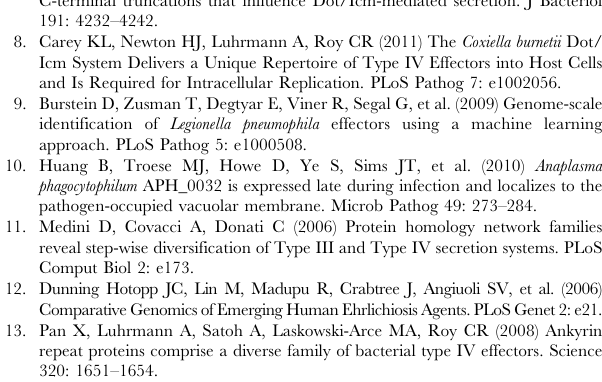
Figure S1 Verification of candidate protein expression. Western blot analysis of L. pneumophila lysates from each expression construct probed with anti-CyaA monoclonal antibody. Table S1 A. marginale str. St. Maries 20 housekeeping genes. Table S2 A. tumefaciens effectors.